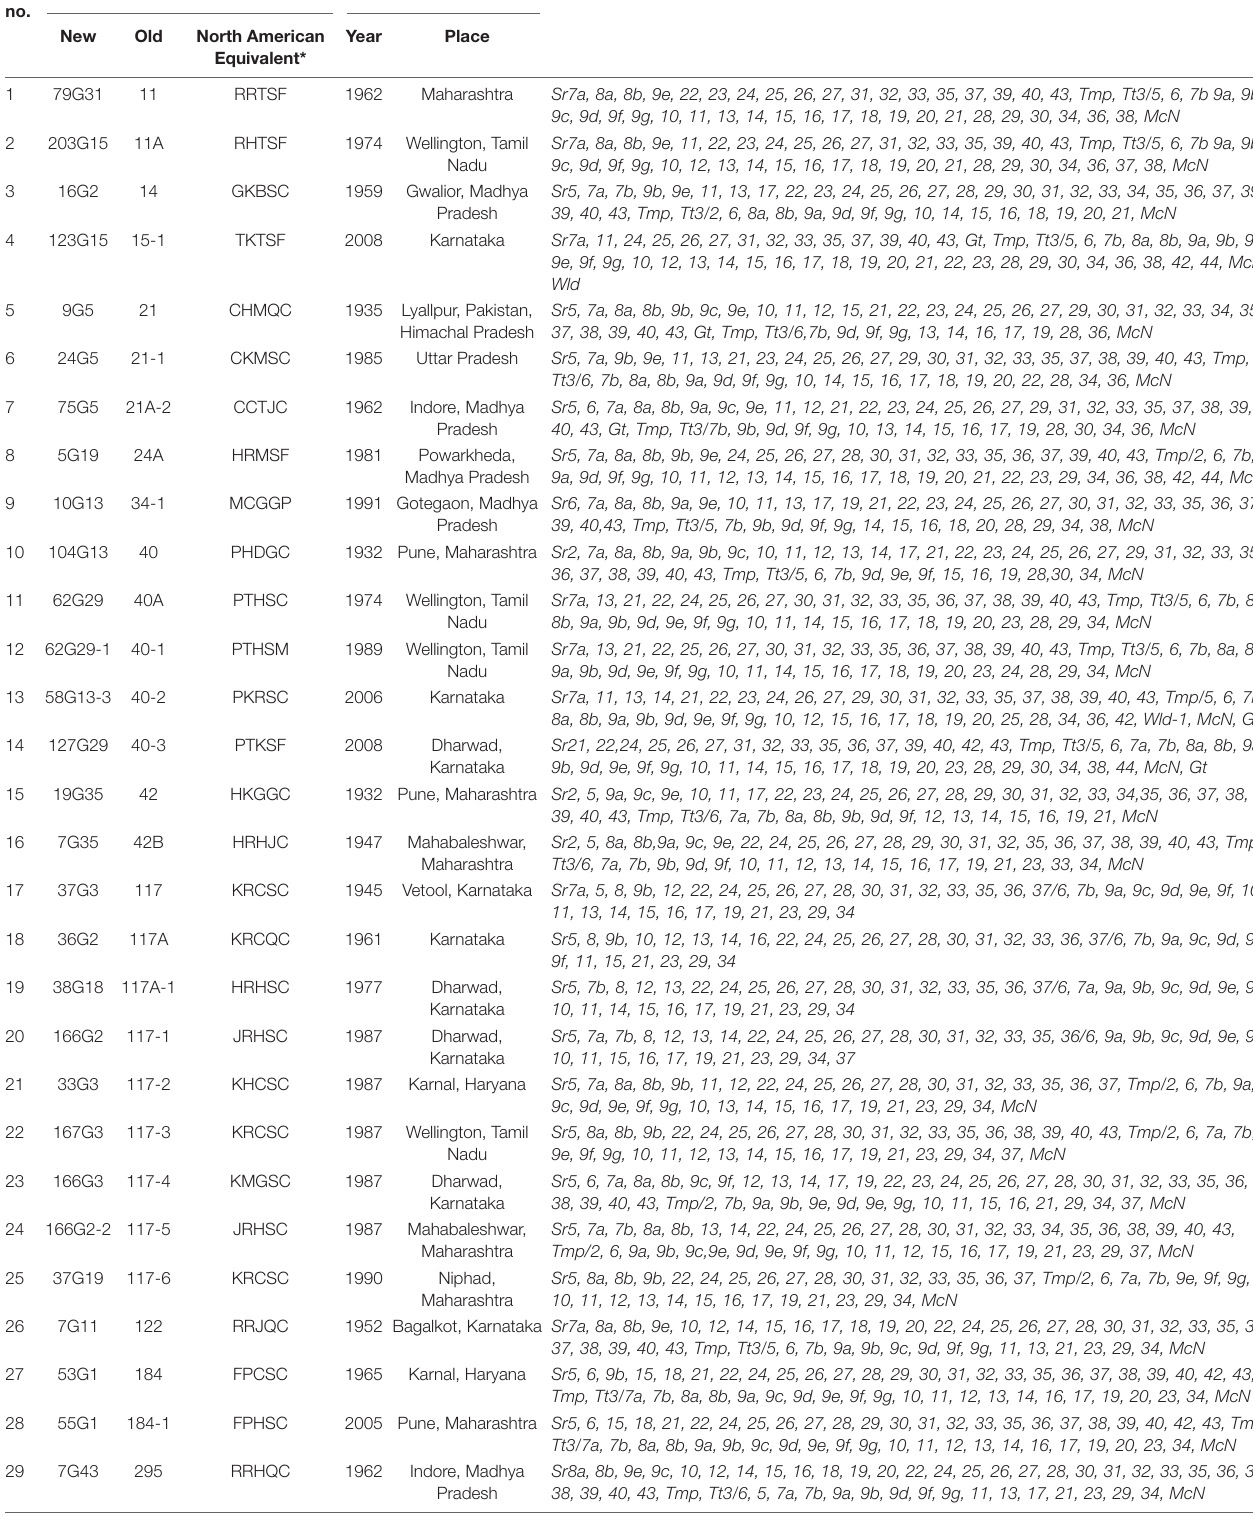
TABLE 1 | Designation, geographic origin, year of identification, and avirulence/virulence formula of 29 pathotypes of Puccinia graminis f. sp. tritici from the Indian subcontinent used to study virulence phenotype and simple sequence repeat (SSR) genotypes. S.